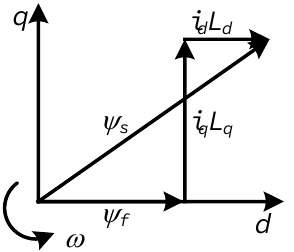
Figure 1. The flux linkage model of a PMSM.